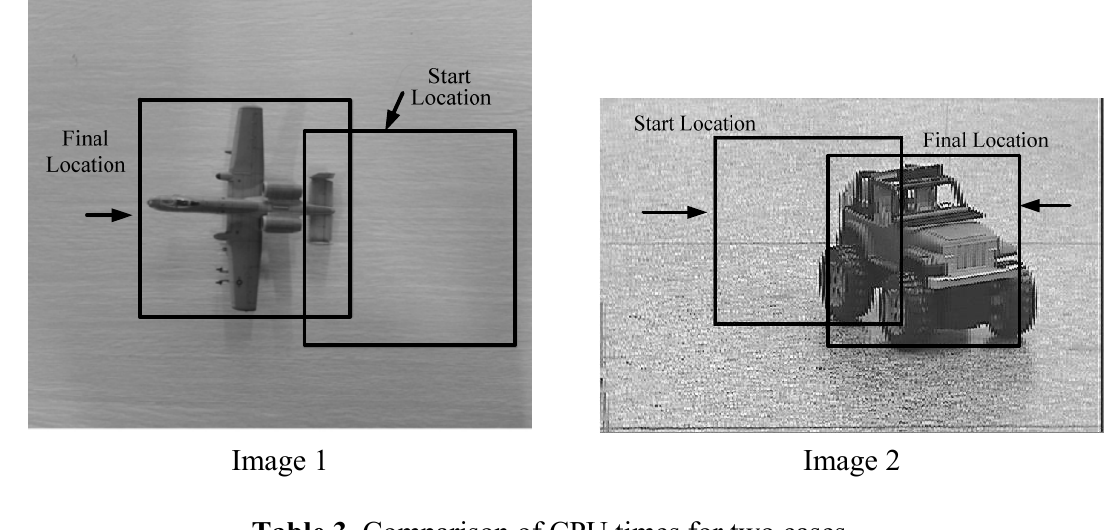
Table 3. Comparison of CPU times for two